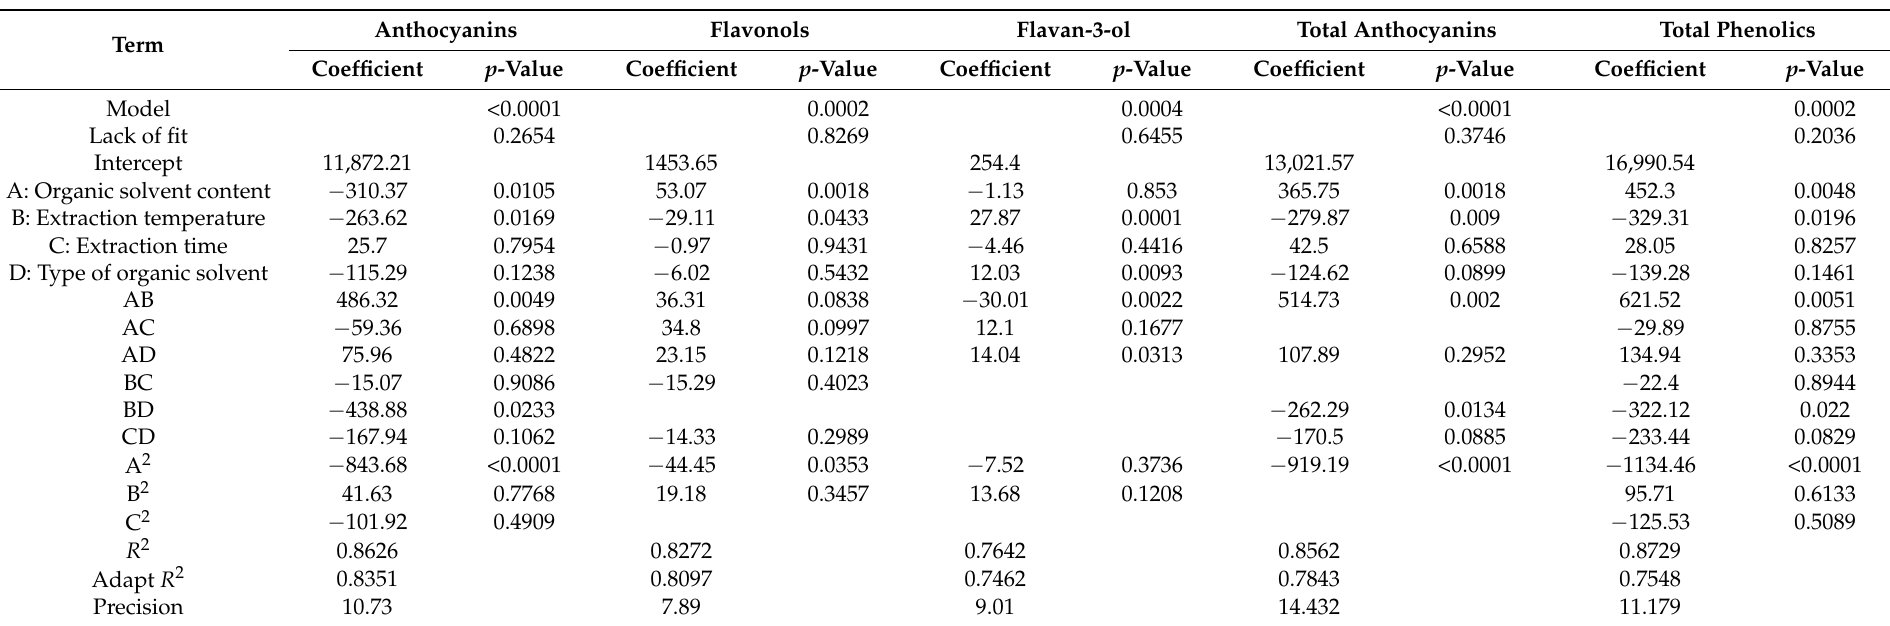
Table 5. Coefficients of the second-order polynomial equation and regression response coefficients and ANOVA parameters for the obtained